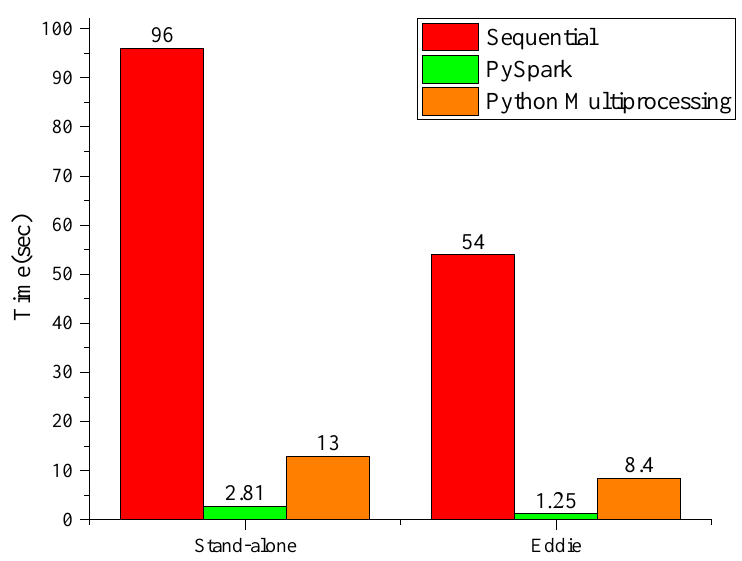
Figure 5. Experimental results of DMAS and its parallel versions using Pyspark and Python mul- tiprocessing on a standalone PC and on Eddie. The results shows that both Spark and Python multiprocessing reduces processing time significantly; however, Spark outperforms Python.